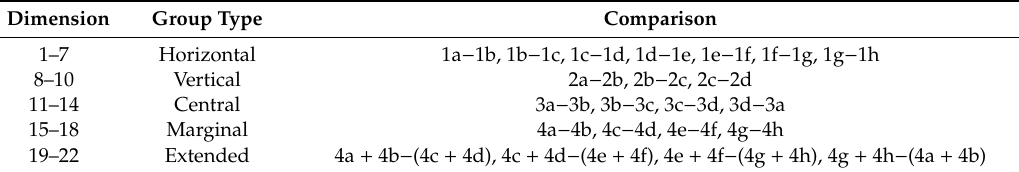
Table 1. Non-reduced fingerprint